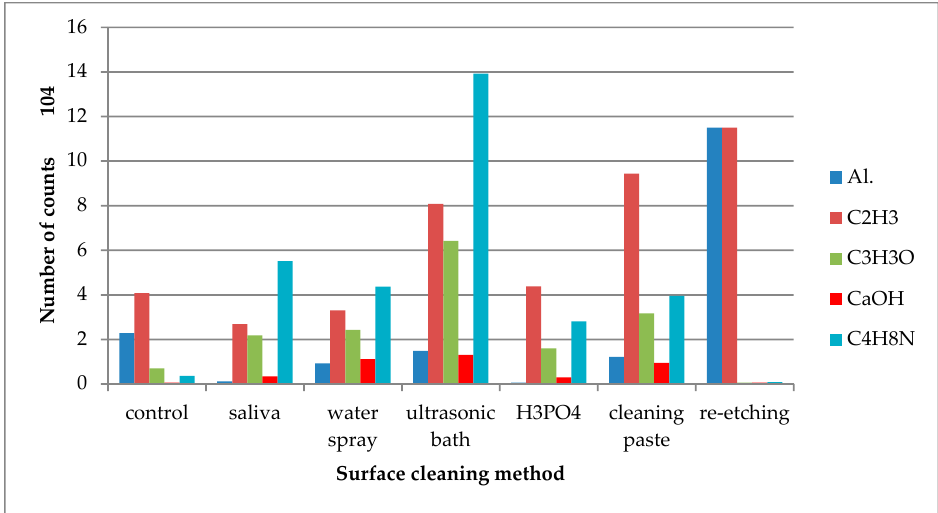
Figure 4. Number of counts of positive ions emitted from the surface of lithium disilicate glass ceramic (LDGC) after various surface cleaning methods.